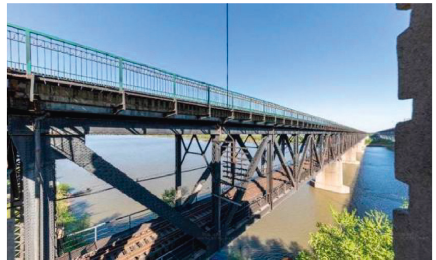
Figure 2: Bin-North line Songhua river bridge.